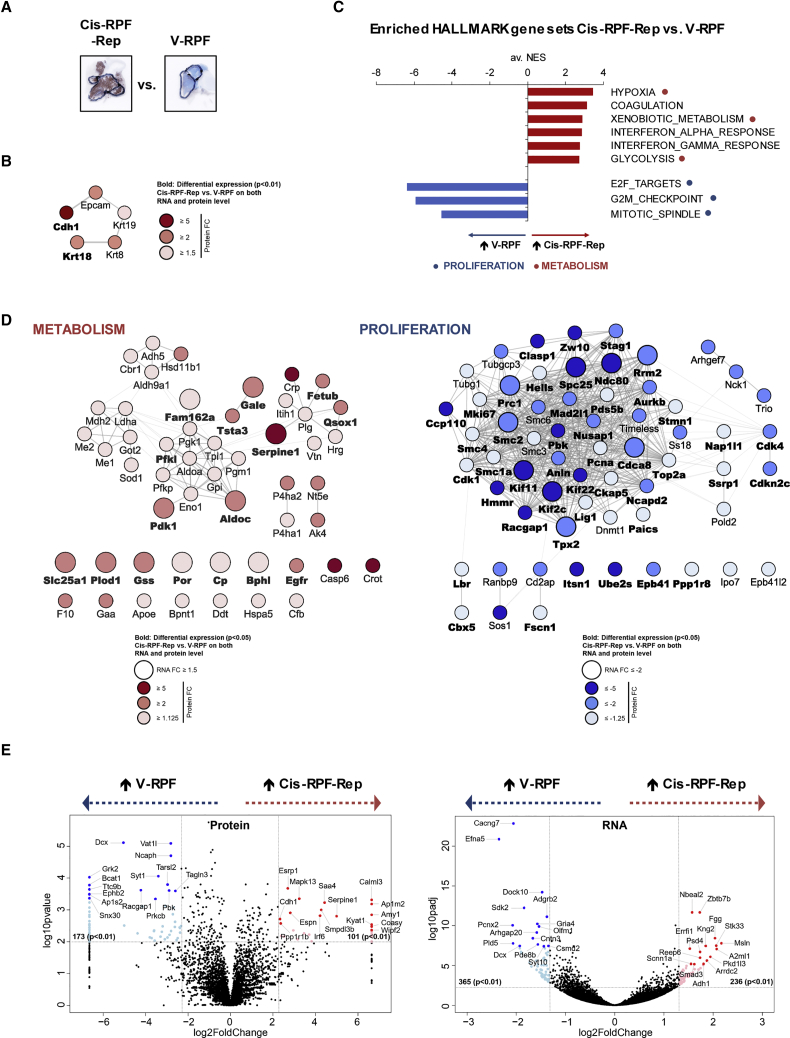
Cisplatin-Treated RPF Samples Display Reduced Proliferation and a Metabolic Switch(A) Representative images (CDH1 staining) of samples used for Cis-RPF-Rep versus V-RPF comparison (for images of all five V-RPF and four Cis-RPF-Rep mice analyzed, see Figure S3A).(B) Functional interaction cluster of significantly (p < 0.01) differentially expressed proteins (determined using beta-binomial test on normalized spectral counts) Cis-RPF-Rep versus V-RPF associated with Cdh1 (STRING database). Node color corresponds to fold change (FC) at the protein level and edge thickness to confidence of STRING interaction (thinnest = high confidence [≥0.7], thickest = highest confidence [≥0.9]). Gene names in boldface type (Cdh1 and Krt18) correspond to proteins that are significantly (p < 0.01) differentially expressed on both protein and RNA level (for RNA-seq data, DESeq2 was used for normalization and differential expression analysis).(C) Common gene sets significantly (FDR q value < 0.05, normalized enrichment score [NES] ≥ 2.5) enriched at both the protein and RNA levels in Cis-RPF-Rep versus V-RPF comparison (GSEA_HALLMARKS). NES values of protein and RNA analyses were averaged for representative purposes (av. NES); separate protein and RNA enrichment graphs can be found in Figure S5B.(D) Network analysis of differentially expressed genes (DEGs; unadjusted p < 0.05), on the basis of proteins contributing to core enrichment of gene sets HYPOXIA, XENOBIOTIC_METABOLISM, and GLYCOLYSIS (“metabolism”) and E2F_TARGETS, G2M_CHECKPOINT, and MITOTIC_SPINDLE (“proliferation”), respectively. Marked in boldface type are genes that were significantly differentially expressed at both the RNA and protein levels. Node color reflects FC at the protein level and node size FC at the RNA level.(E) Most discriminatory genes in Cis-RPF-Rep versus V-RPF comparison. All genes with p values < 0.01 and −5 ≥ FC ≥ 5 (protein, left plot) or −2.5 ≥ FC ≥ 2.5 (RNA, right plot) are colored in light blue (UP in vehicle-treated) or light red (UP in cisplatin-treated RPF-Rep), respectively. Highlighted with proteins names (and marked with dark blue and red dots) are the 15 most highly differentially expressed genes in each direction (by p value after FC filtering).See also Figures S3–S5 and Tables S2, S3, and S4.